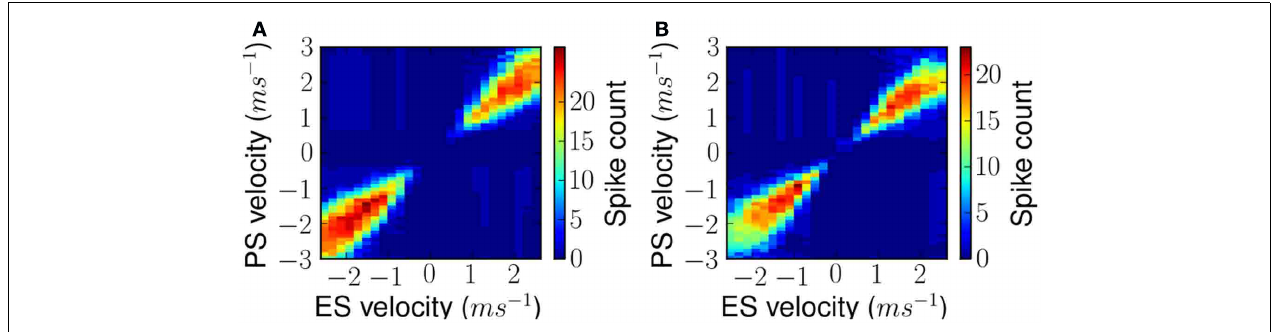
FIGURE 10 | Measured FM sweep tuning curves after exposure as shown in Figure 9 but for all exposure stimuli. (A) Results for simple linear FM stimuli and (B) results for forked stimuli.